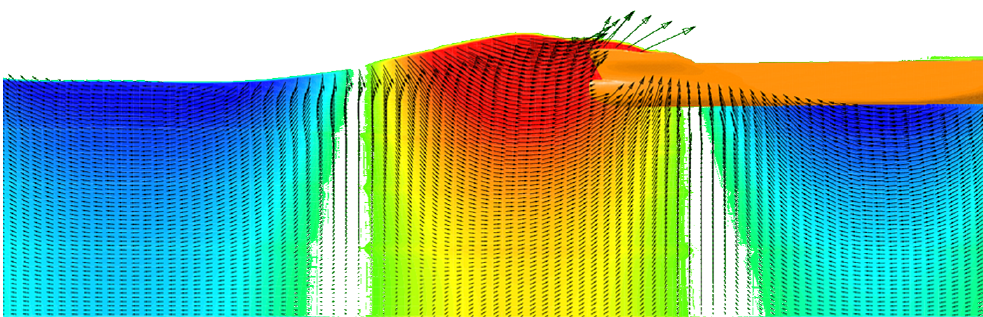
Figure 14. Exemplary field method computed pressure and velocity distribution in the fluid domain surrounding the chemical tanker at the symmetry plane (y = 0). An extreme wave ( H λ 200 m) impinges the vessel’s bow. The orbital velocity field of the wave crest and wave troughs ≈ are cut off from the sea-bed (indicated by solid